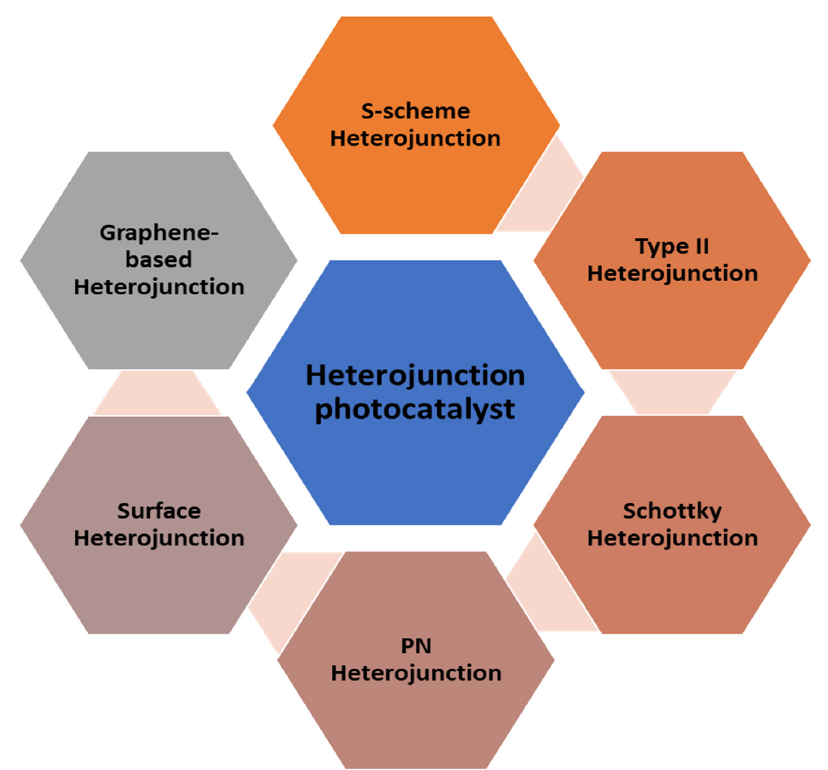
Figure 4. Various types of heterojunction photocatalyst material.